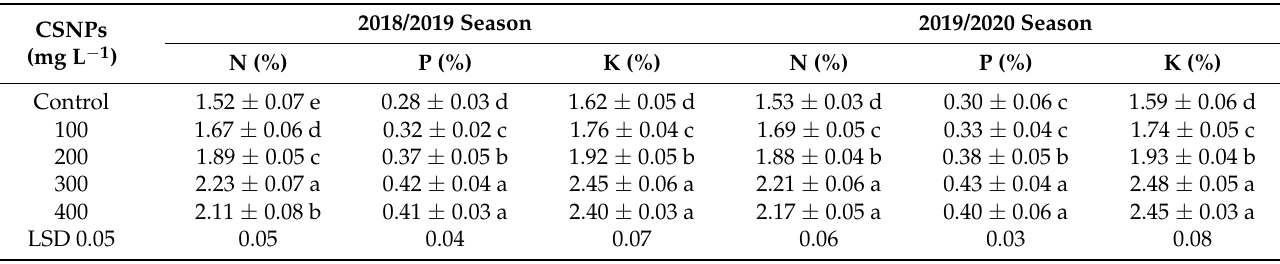
Figure 3. Impact of chitosan nanoparticles (CSNPs) on ( A ), total phenolic content and ( B ), antioxidant activity of Matricaria chamomilla in the two experimental seasons. Data are means ± SE ( n = 3). In each season, letters represent statistical differences among the treatments at 5% probability. Table 3. Impact of chitosan nanoparticles (CSNPs) on N, P and K percentages of Matricaria chamomilla in the two experimental seasons. Data are means ± SE ( n = 3). In each column, least significant difference was calculated and letters represent the statistical differences among treatments at p ≤